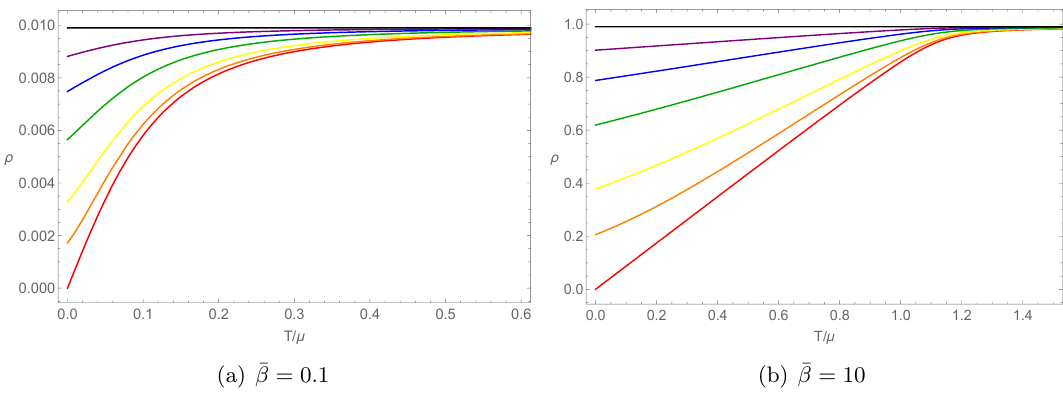
(b) (cid:22) (cid:12) = 10